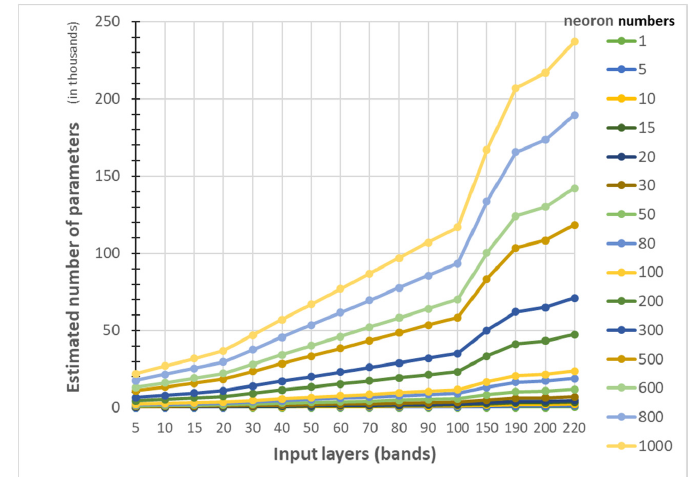
Figure 11. Estimated number of parameters with the associated number of input layers (bands).